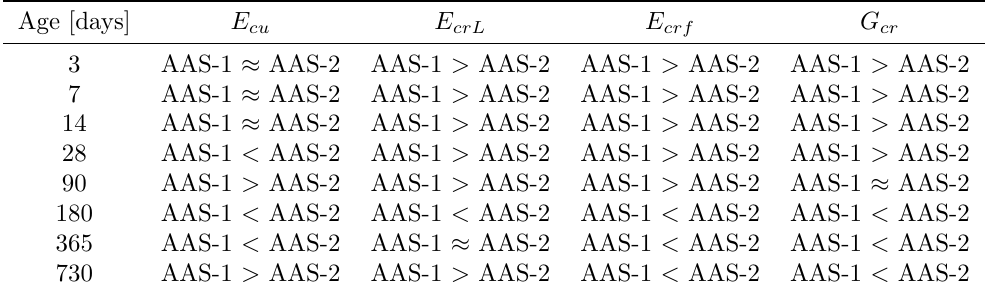
Table 1. A statistical comparison of test results with and without SRA: where the results show no statistically significant difference, the table says “AAS-1 ≈ AAS-2”; where they do, the table uses a “greater-than” or “less-than” sign accordingly.